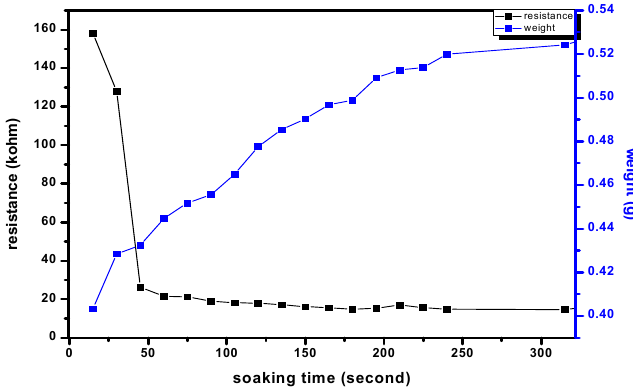
Figure 3. The variations are electrode resistance as well as hydrogel mass with soaking time.